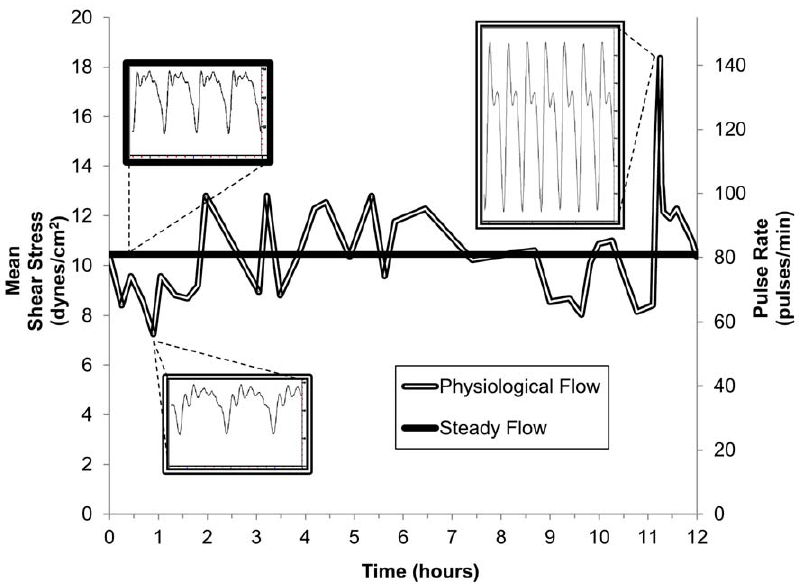
Figure 2. Physiologically modeled perfusion culture. A 12–hour perfusion regime (hollow line) was developed by programming a series of real-time recordings in heart rate obtained in a healthy male subject into peristaltic pumps as ramp changes. For comparison, the average shear stress magnitude calculated over the entire 12–hour cycle (10.3 dynes/cm 2 at 80 pulses/min) was programmed as steady pulsatile flow (dark line). Mean wall shear stress and pulse frequency experienced by the endothelial cells within parallel plate flow chamber over time are shown on the left and right axes, respectively. Insets show pressure waveforms experienced at various time points during steady (dark border) or physiological flow (hollow border). doi:10.1371/journal.pone.0057004.g002 cell membrane, was upregulated by PF only (2.107 6 0.297-fold, p = 0.035). However, cytosolic phospholipase A2 gamma ( PLA2G4C ) expression was upregulated irrespective of flow (SF: 3.190 6 0.501, p =0.015, PF: 2.966 + 0.293, p = 0.036).